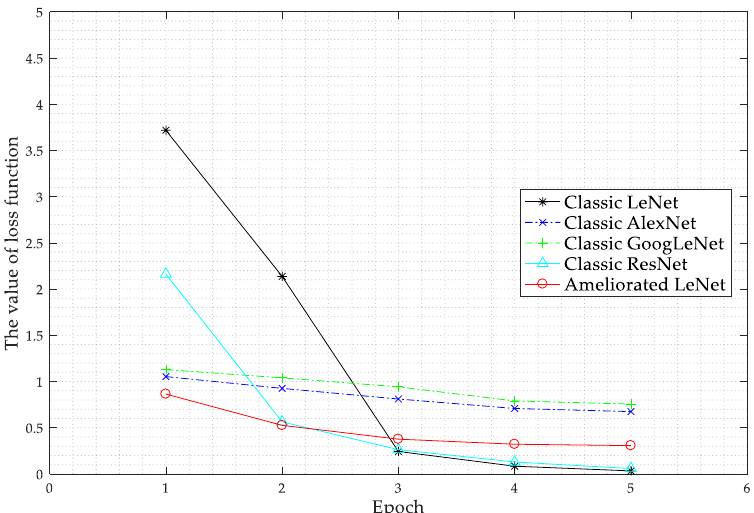
Figure 17. The value of loss function changing over epochs for the different network models compared.